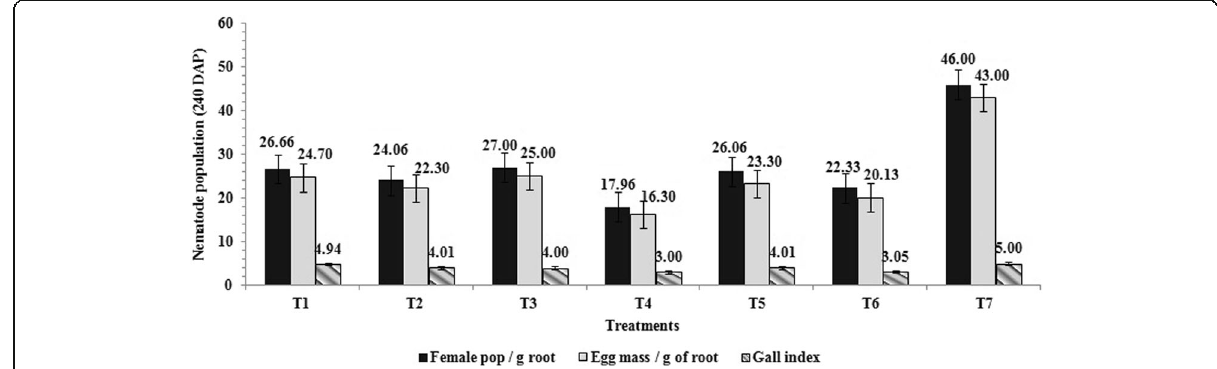
Fig. 6 Root population of root-knot nematode in gerbera under green house